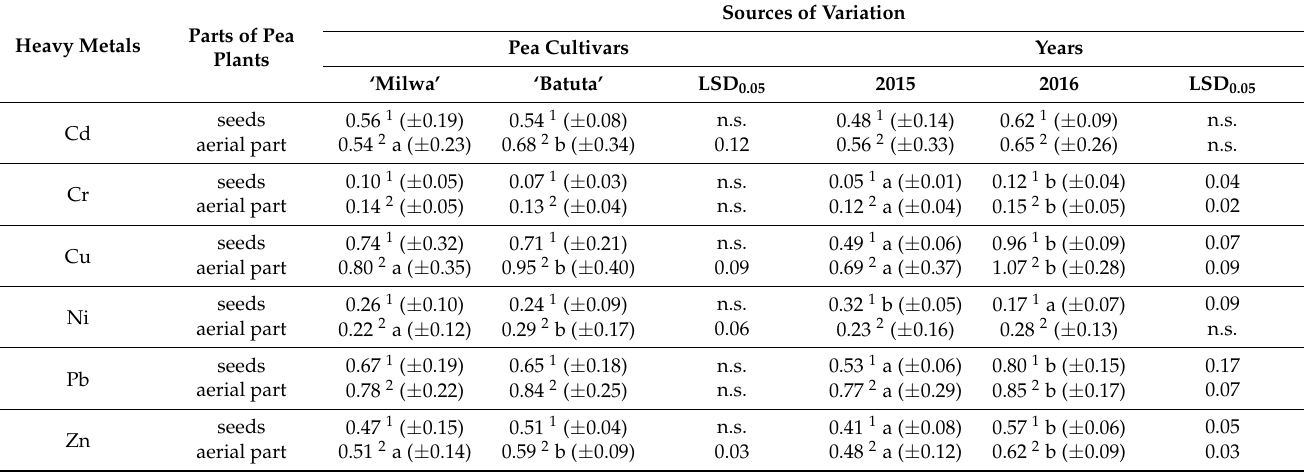
Table 12. TF of heavy metals in pea plants ( 1 mean values in maturity ± SD of two successive years or two cultivars, respectively, and with three repetitions each; 2 mean values ± SD of six growth stages, two successive years or two cultivars, respectively, and with three repetitions